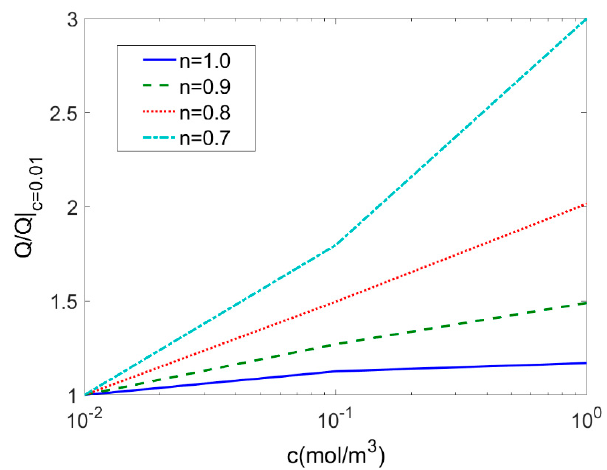
Figure 10. Variation of the total flow rates generalized by the total flow rate when c = 0.01 mol / m 3 with electrolyte concentration at di ff erent flow behavior indices n ( ζ = − 0.1 V, V = 10 V, L = 20 µ m, φ =